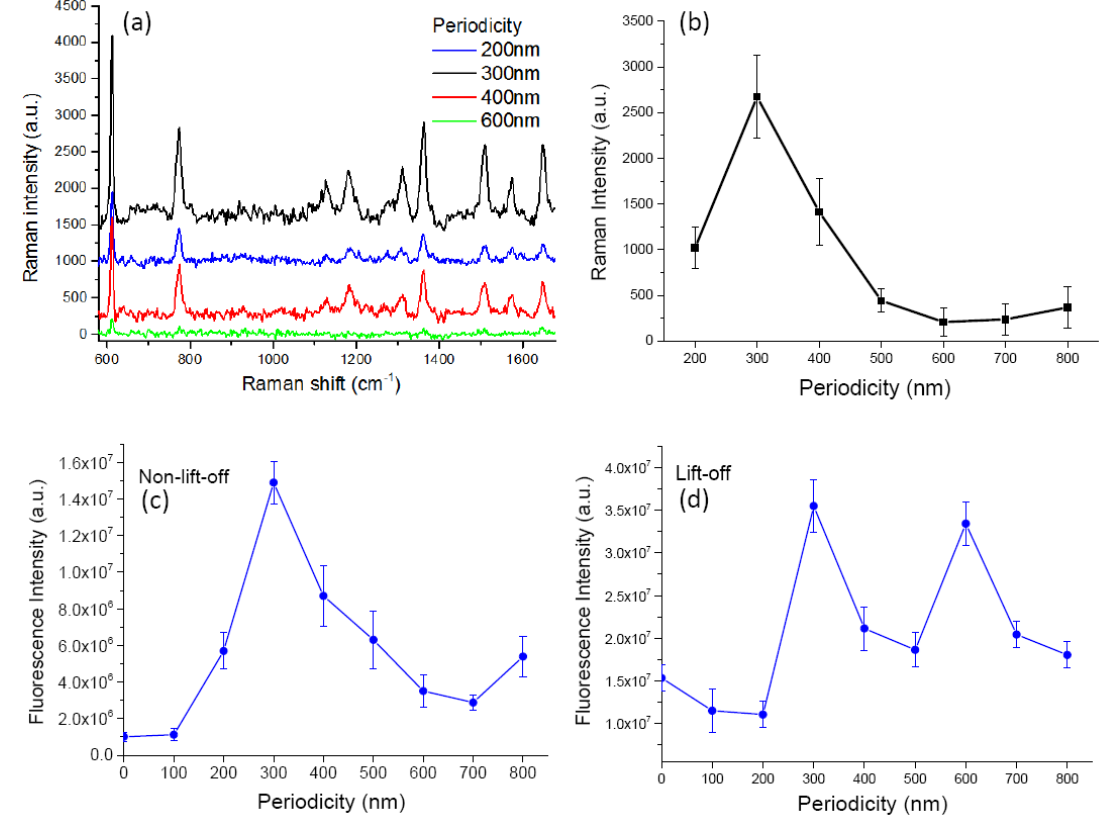
Figure 6. ( a ) Background corrected SERS spectra from nonlift-off nanogratings labeled with proteins. The spectra are vertically shifted for visual clarity. ( b ) The dependence of Raman intensity versus grating periodicity. ( c ) The periodicity dependence of fluorescence intensity on nonlift-off nanogratings. ( d ) The periodicity dependence of fluorescence intensity on lift-off nanogratings.